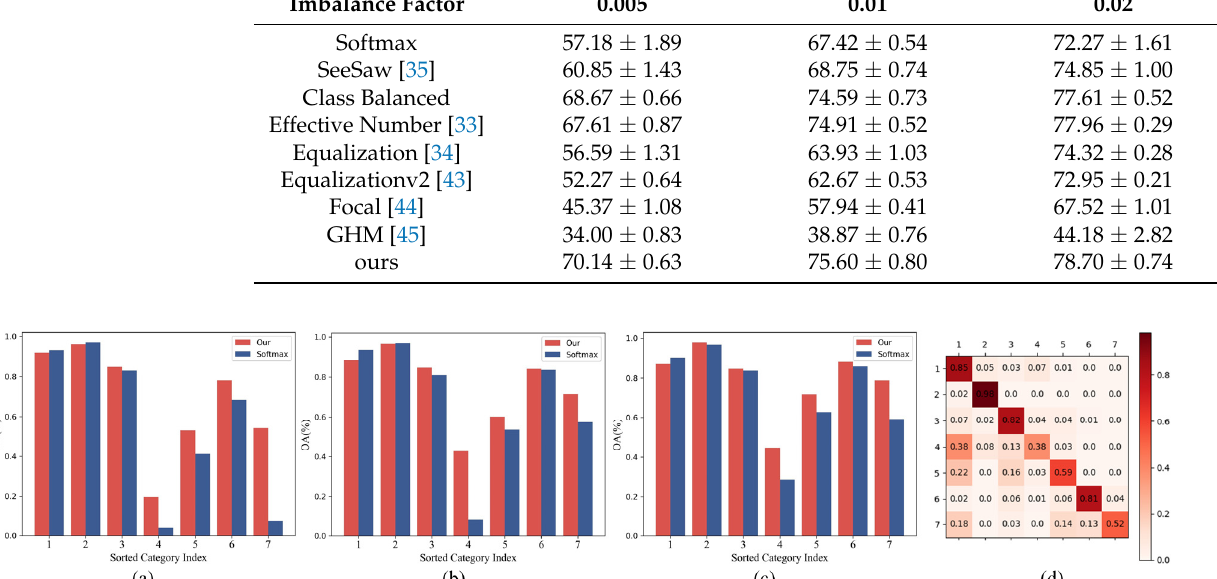
Figure 6. ( a – c ) show the classification accuracy of the proposed method and Softmax cross-entropy method for samples from each category in the long-tailed HistAerial dataset with imbalance ratios of 0.005,0.01, and 0.02, respectively. ( d ) shows the classification confusion matrix of the proposed method on the long-tailed HistAerial dataset with an imbalance ratio of 0.005.